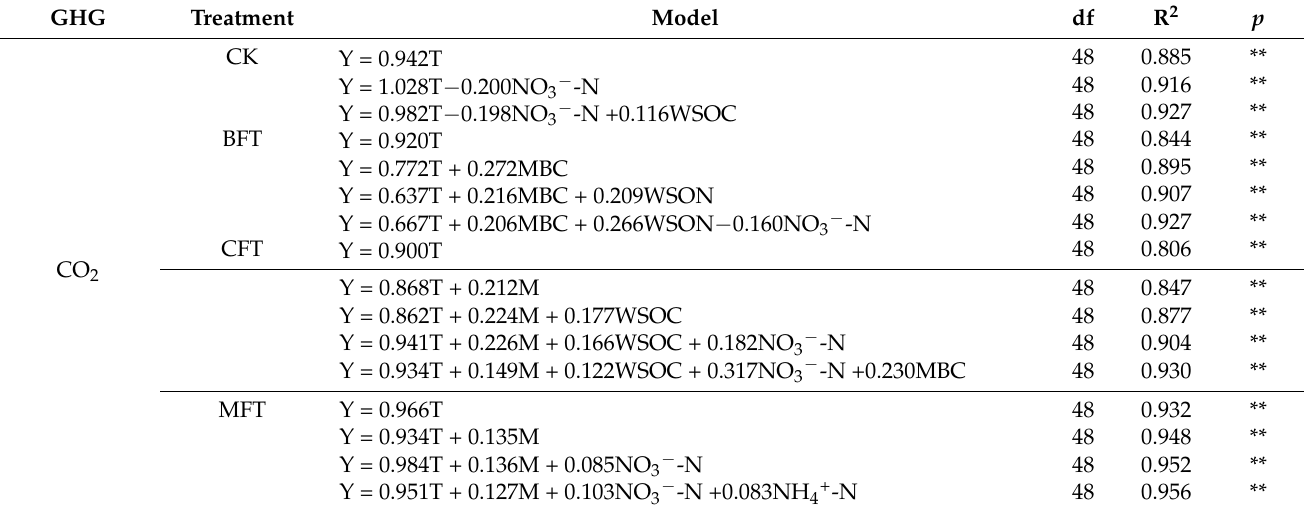
** indicate significance at p < 0.001.